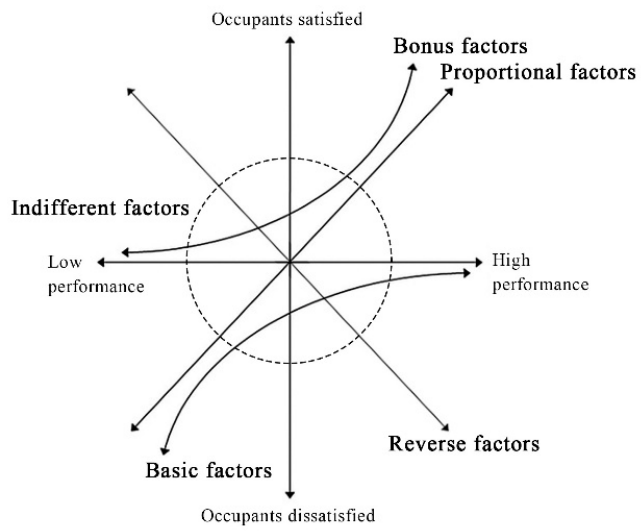
Figure 4. Quality categories in the Kano model (adapted from reference [76]).